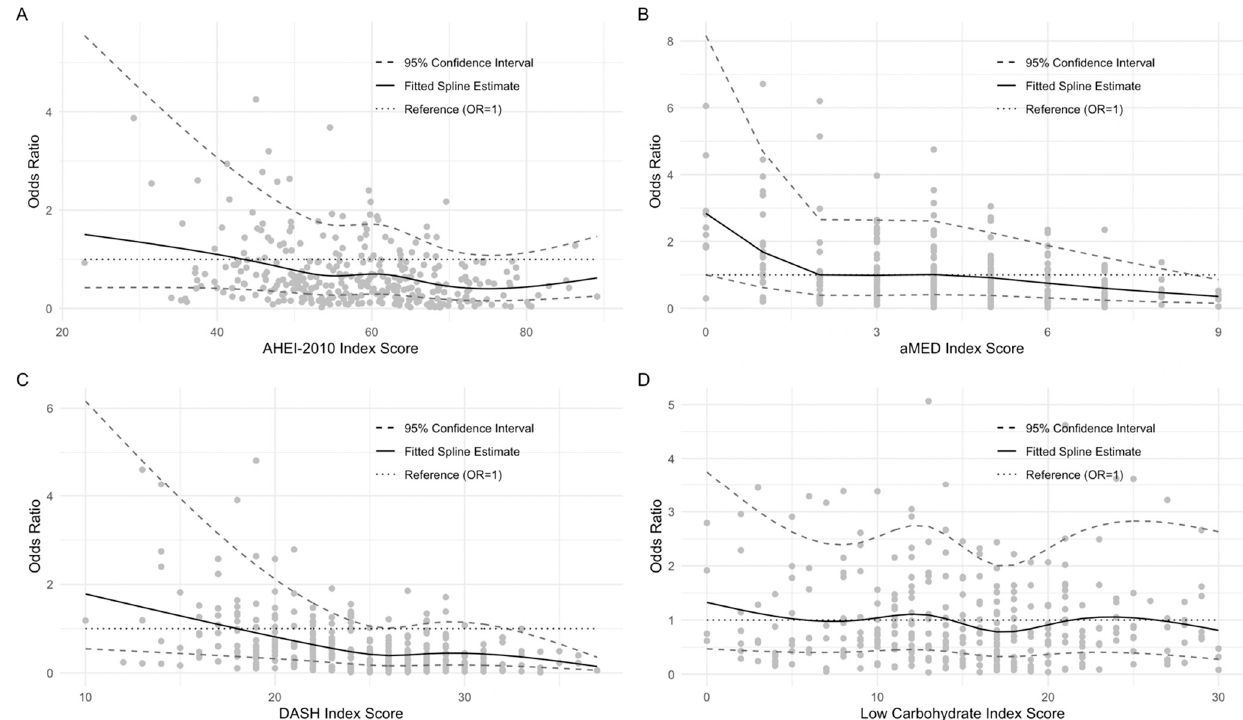
Figure 1. Dose–response relationship between each dietary index, modeled as a continuous variable, and NIS symptom summary score ≥ 12 1-year postdiagnosis. All multivariable models were adjusted for the same set of covariates in Table 5. Restricted cubic splines models were fit to mappings of each of the observations, according to their ( A ) AHEI-2010, ( B ) aMED, ( C ) DASH, or ( D ) low-carbohydrate index scores, to their respective odds. The odds corresponding to the median intake level for each dietary index were set as referents. Dashed lines indicate 95% confidence bounds. The dotted line indicates OR = 1, which was included for reference.